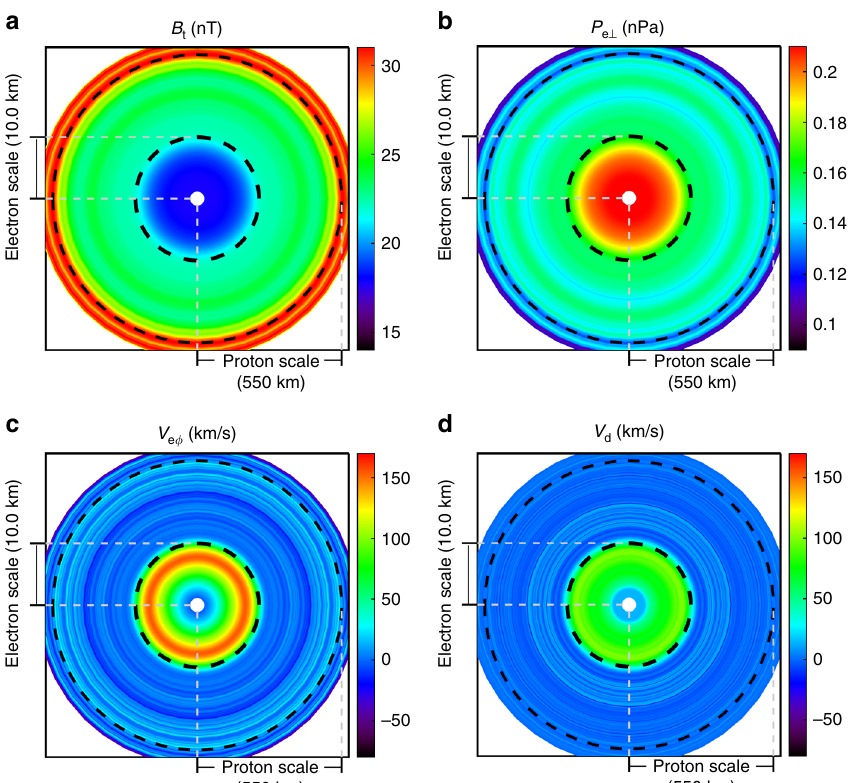
Fig. 6 The electron scale magnetic cavity embedded in the proton scale magnetic cavity. Panels a – d denote the magnetic fi eld strength ( B t ), electron perpendicular pressure ( P e ⊥ ), tangential bulk velocity ( V e ϕ ), and the estimated diamagnetic drift velocity ( V d ), respectively. In each panel, the origin is set to be the center of the ESMC, and the distance is in log scale (from 0.5 to 780 km). Each 2D distribution, derived from observations, is regarded as a function of the distance to the center of the ESMC. The small white region near the center is due to the absence of